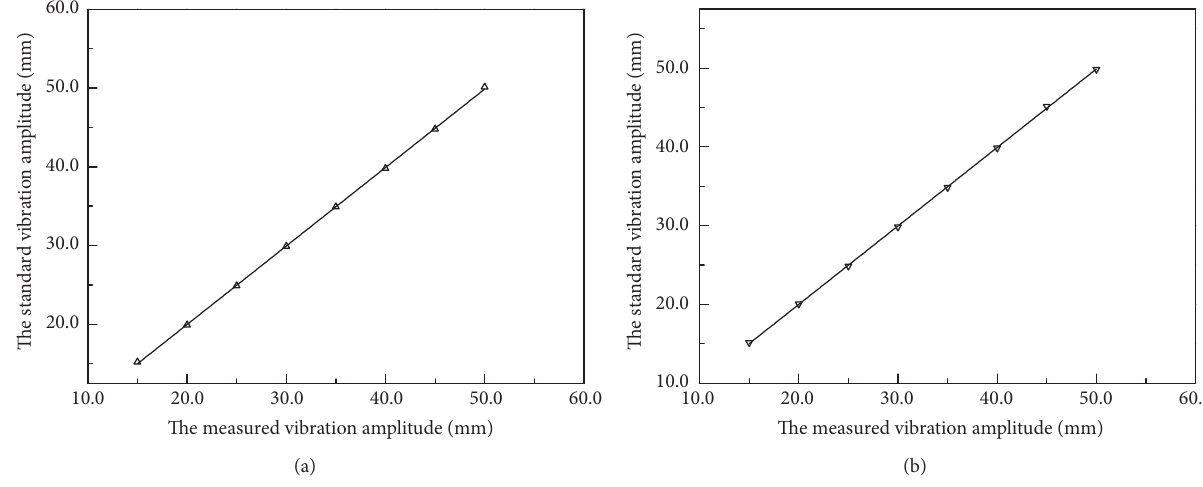
Figure 4: Fitted curves for calibration of two acceleration transducers. (a) In-line direction and (b) transverse direction.